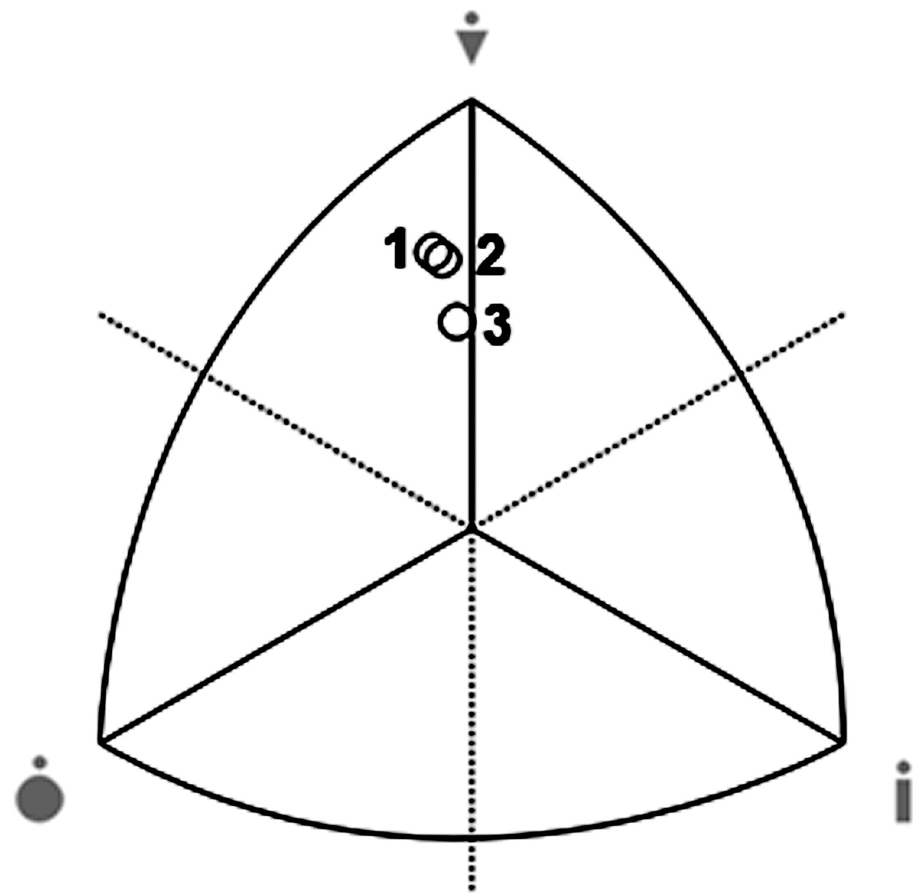
Fig 1. Distribution of somatotypes in groups of handball players (1 –super league, 2 – 1 st league, 3 –academic players).